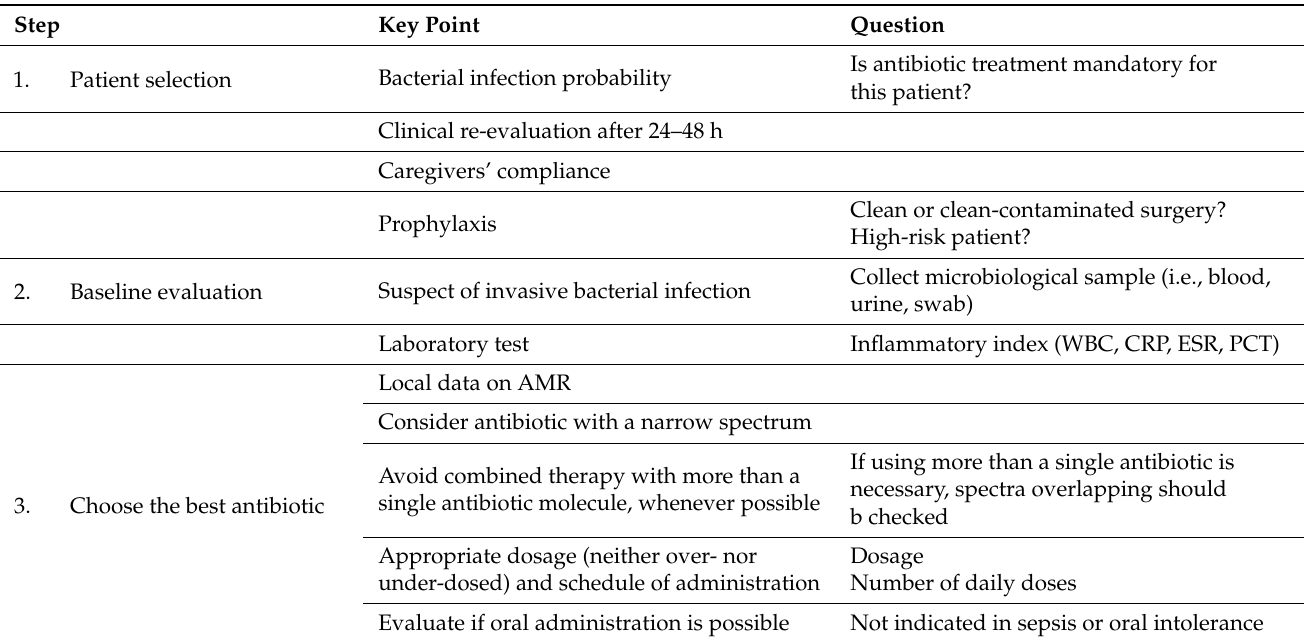
Table 2. Assessment list for prescribing